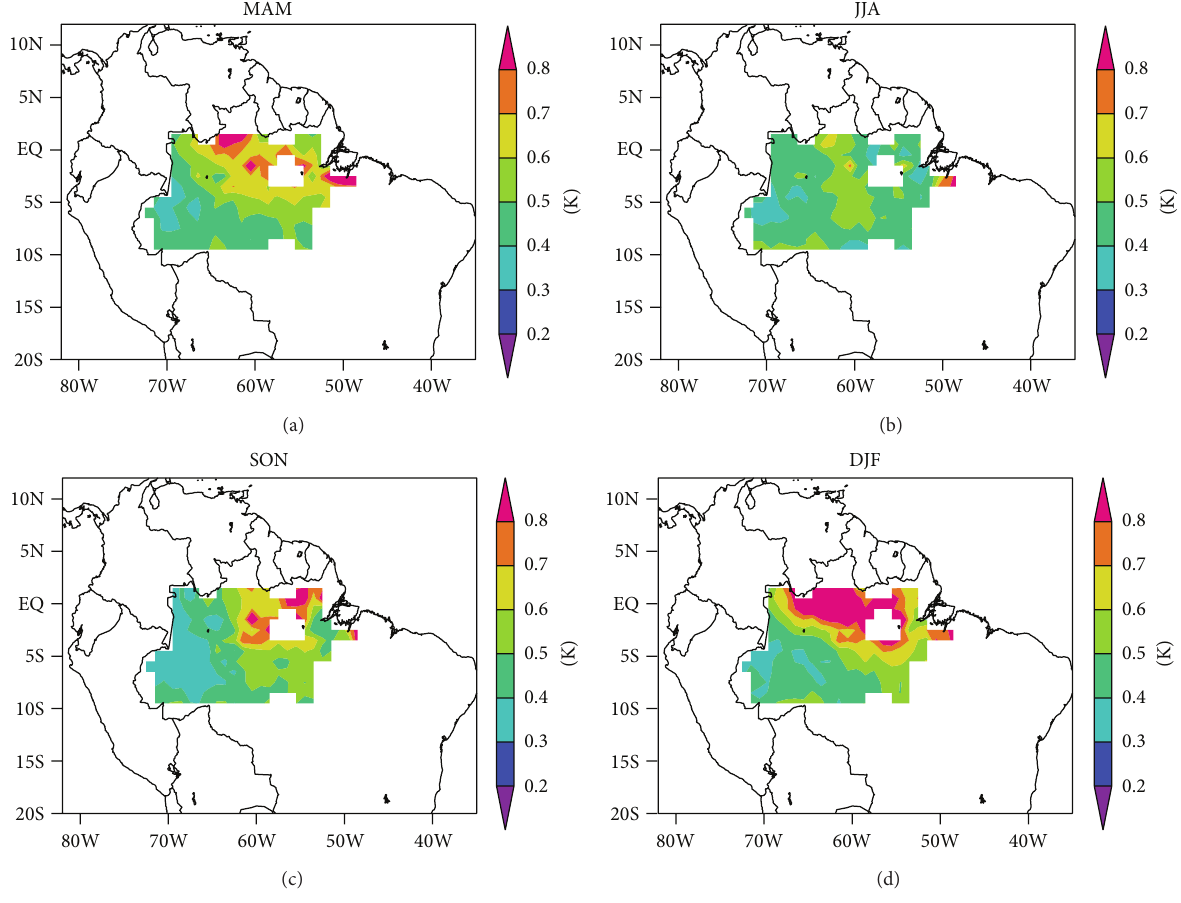
Figure 5: The same as Figure 4 but at 6:30